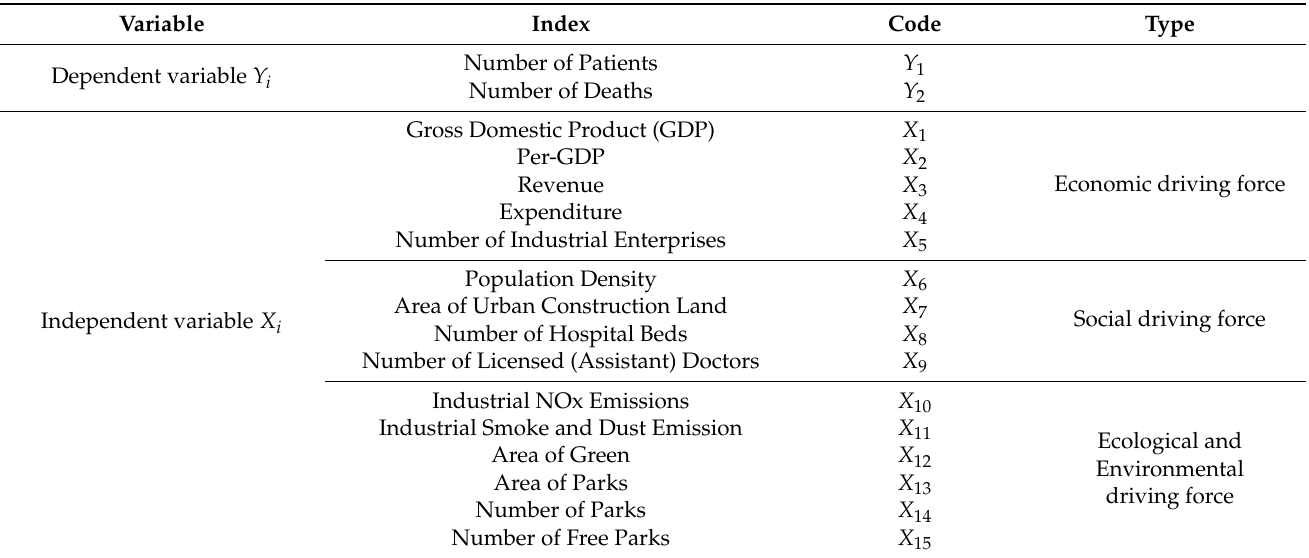
Table 2. Model variable